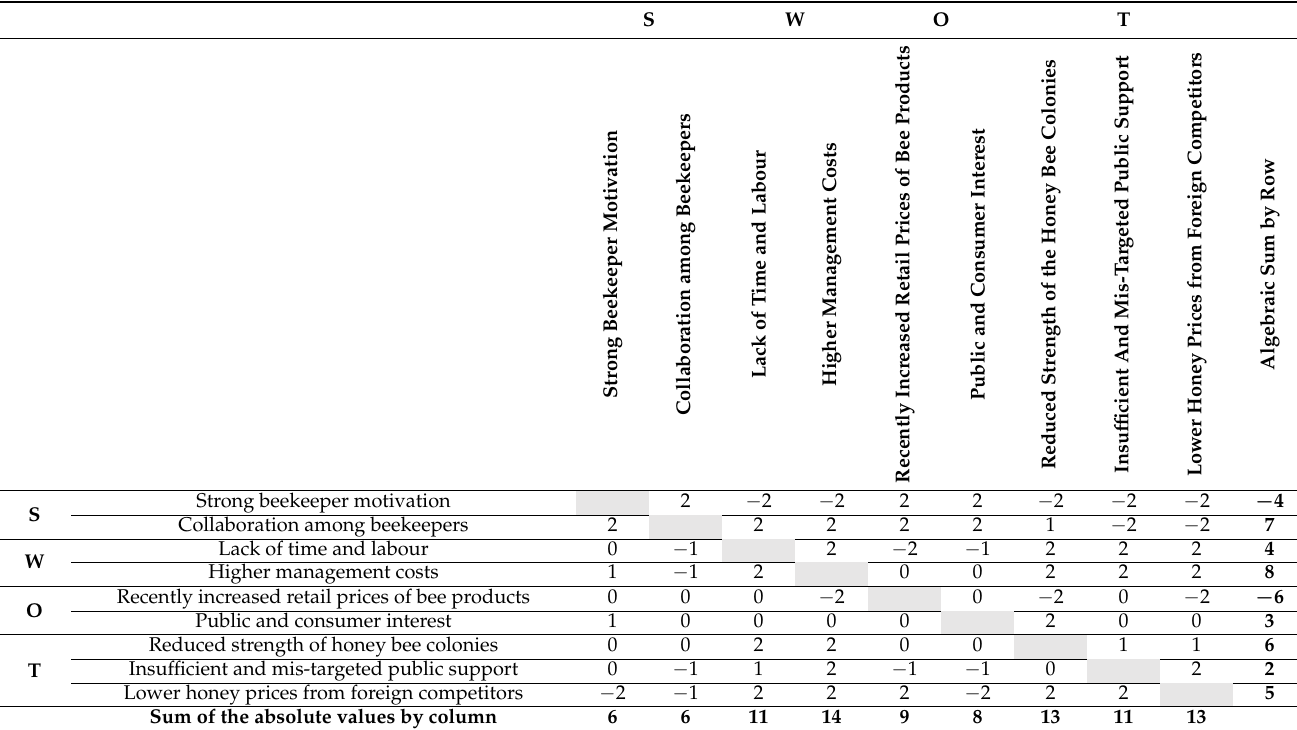
Table A1. Pairwise comparison of the SWOT items by beekeeper association leaders.